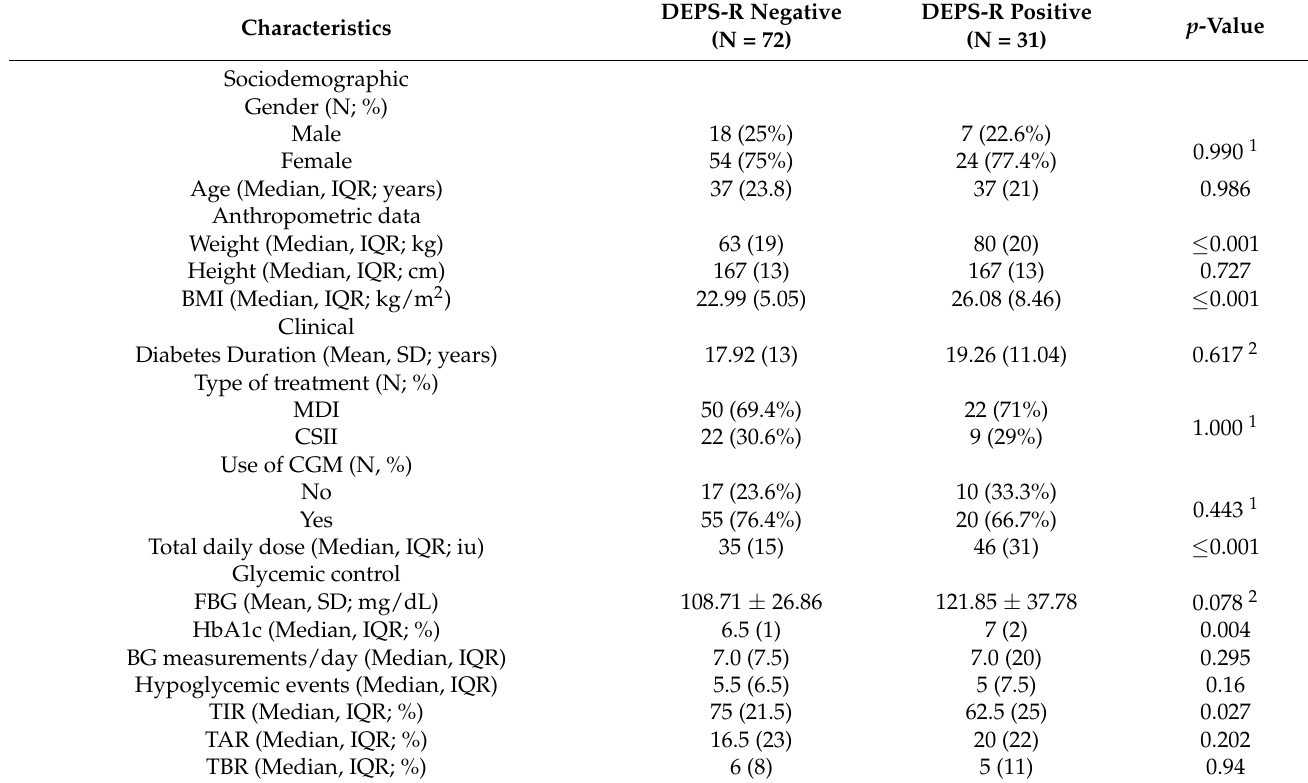
Table 2. Characteristics of patients with type 1 diabetes mellitus (T1DM) according to the score on the Diabetes Eating Problem Survey-Revised Version (DEPS-R) (cut-off score 20) (N = 103).